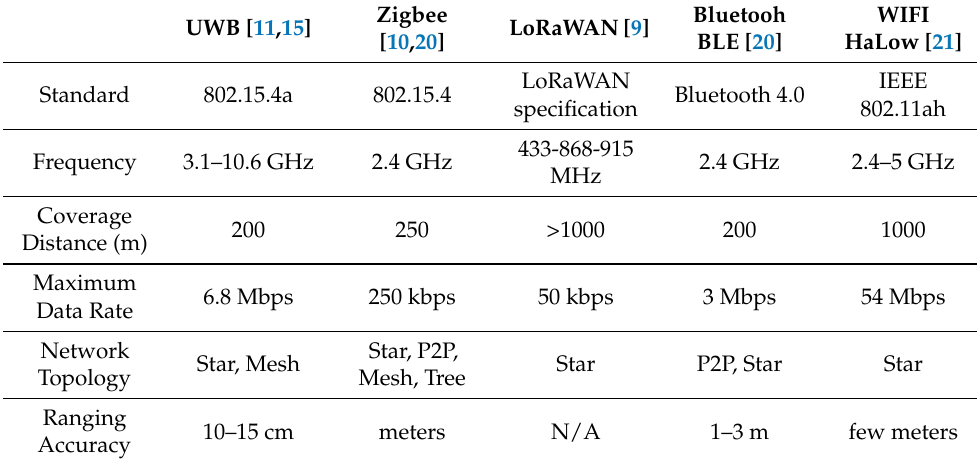
Table 1. Comparison between different technologies for